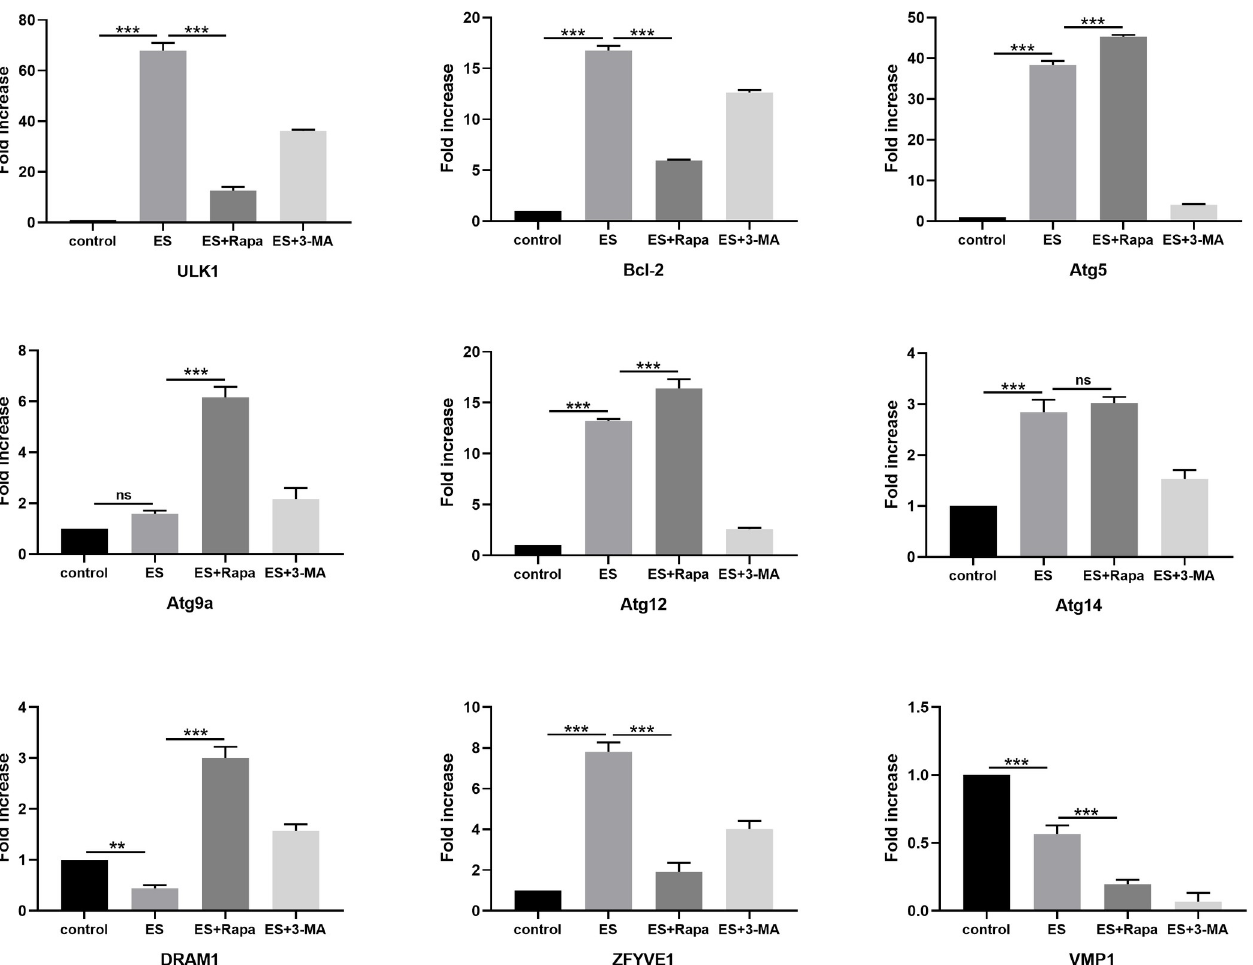
Fig 7. Changes in transcriptional level of additional autophagy-related markers in ES-treated myoblasts. Expression of ULK1, Bcl-2, Atg5, Atg9a, Atg12, Atg14, DRAM1, ZFYVE1, and VMP1 mRNA in myoblasts treated with or without 1 μ g/ml ES, rapamycin (100 nM), and 3-MA (5 mM) for 3 h. The data represent at least 3 independent experiments and are expressed as mean ± SD. p < 0.05( � ), p < 0.01( �� ), p < 0.001( ��� ), ns = no significance.